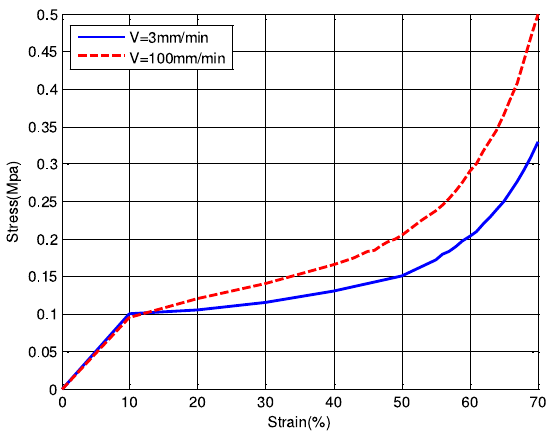
Figure 7. Stress-strain curves of crushable PUR foam under quasi- static loadings in two